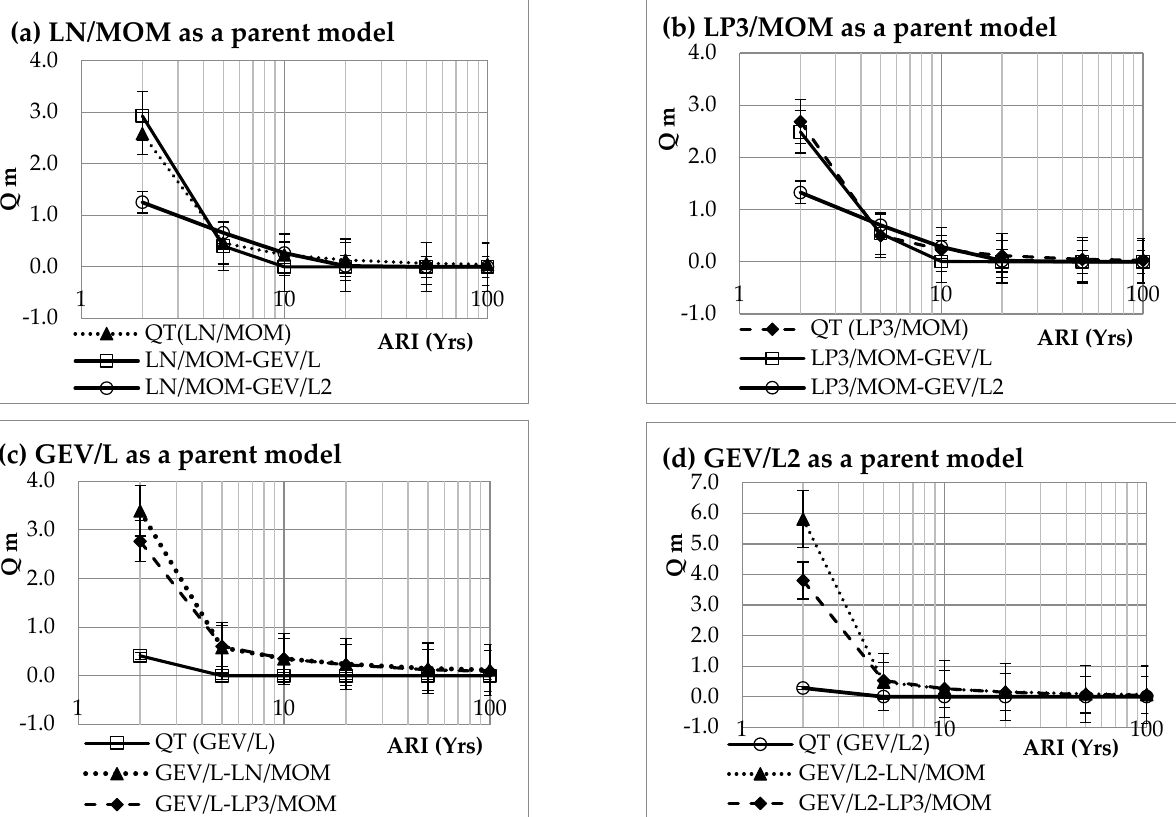
Figure 4. Comparison of the 7-day mean quantile estimate (Q m) of catchment A4260557 (dry catchment) at D/S Mt. Barker when data were generated from another model. Error bars indicate standard error.